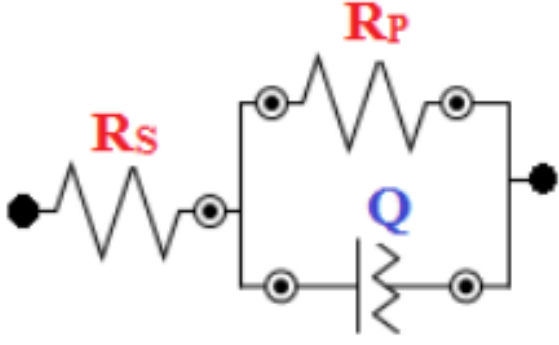
Figure 7. Equivalent circuit used for Nyquist plot analysis.